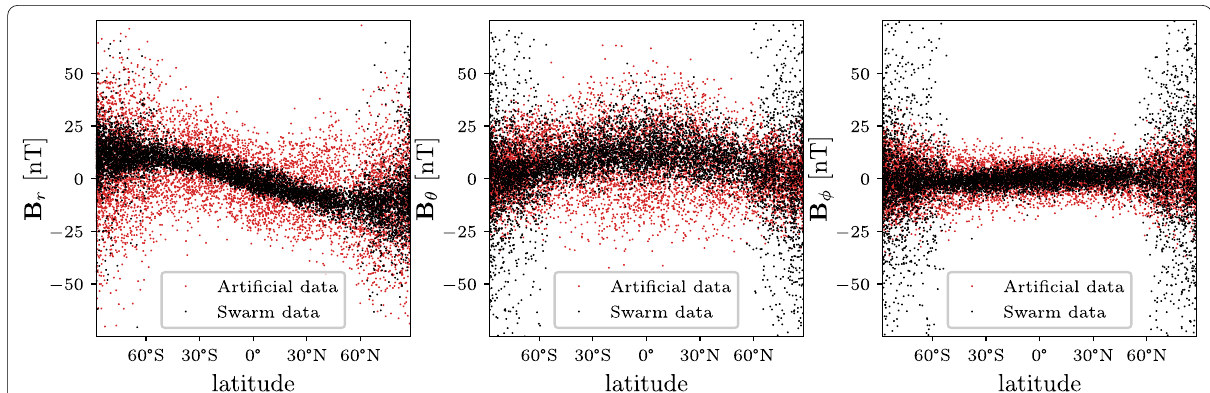
Fig. 14 Comparison of the selected (nighttime and geomagnetic low activity) vector field magnetic satellite measurements. The residuals from the core and lithosphere component are shown. The artificial data used in the presented OSSE are marked in red; the real Swarm observational data are marked in black. All three vector field components ( B r , B θ , B φ ) are shown for each 100th satellite measurement of year 2014 in dependence on the satellite latitude